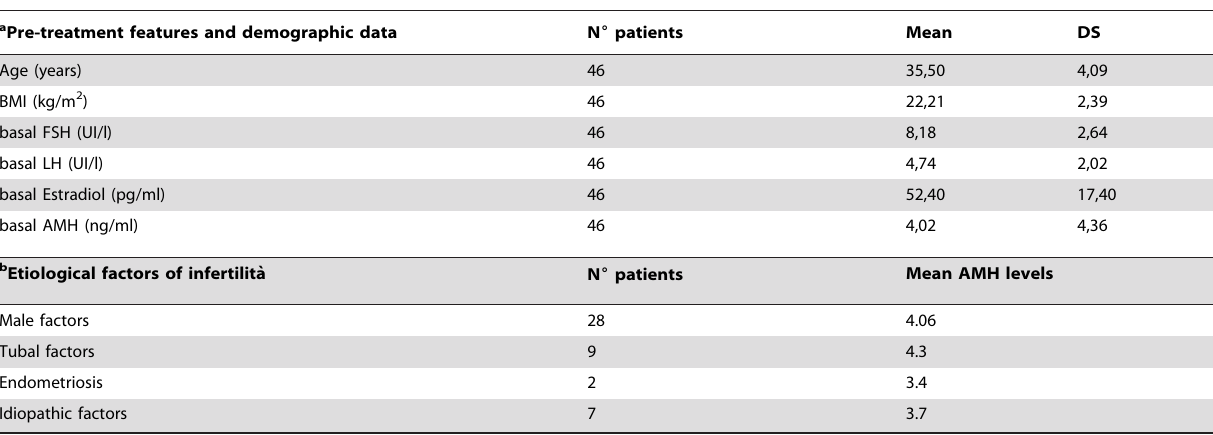
Table 1 a ,b . Pre-treatment features, patient demographic data and mean AMH levels for different etiological factors of infertility.